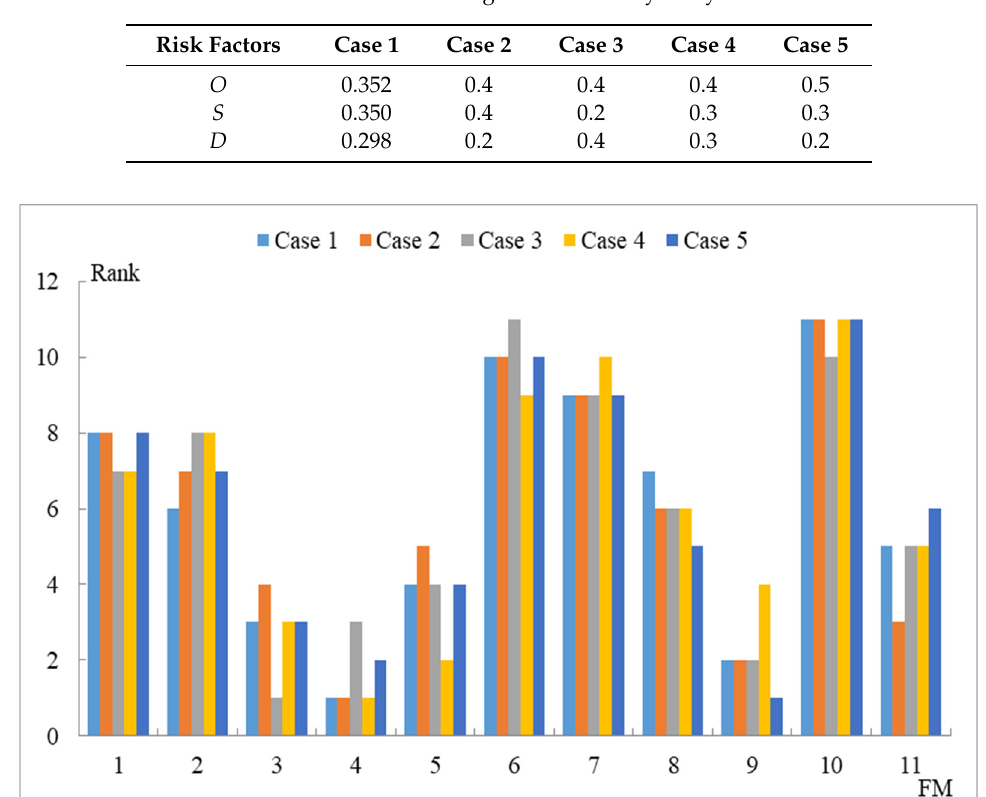
Figure 2. Results of sensitivity analysis for different risk factor weights.